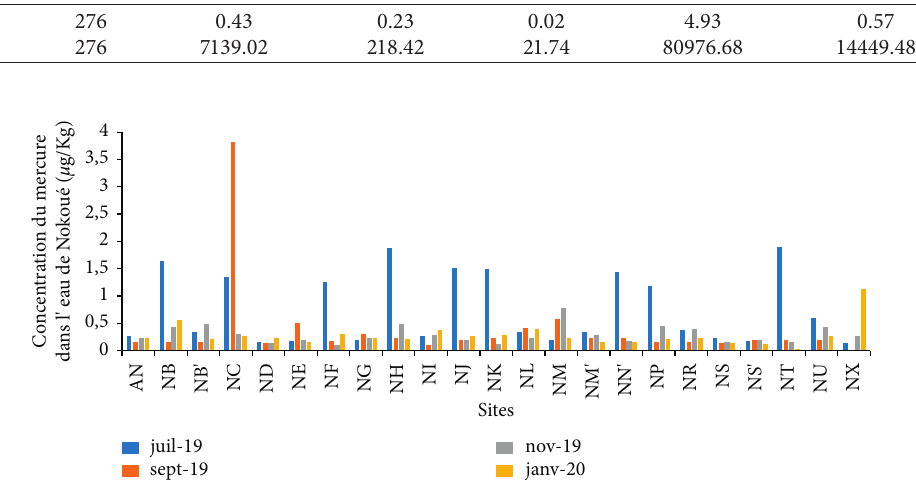
Figure 6: Variation in the concentration of mercury in the water of Lake